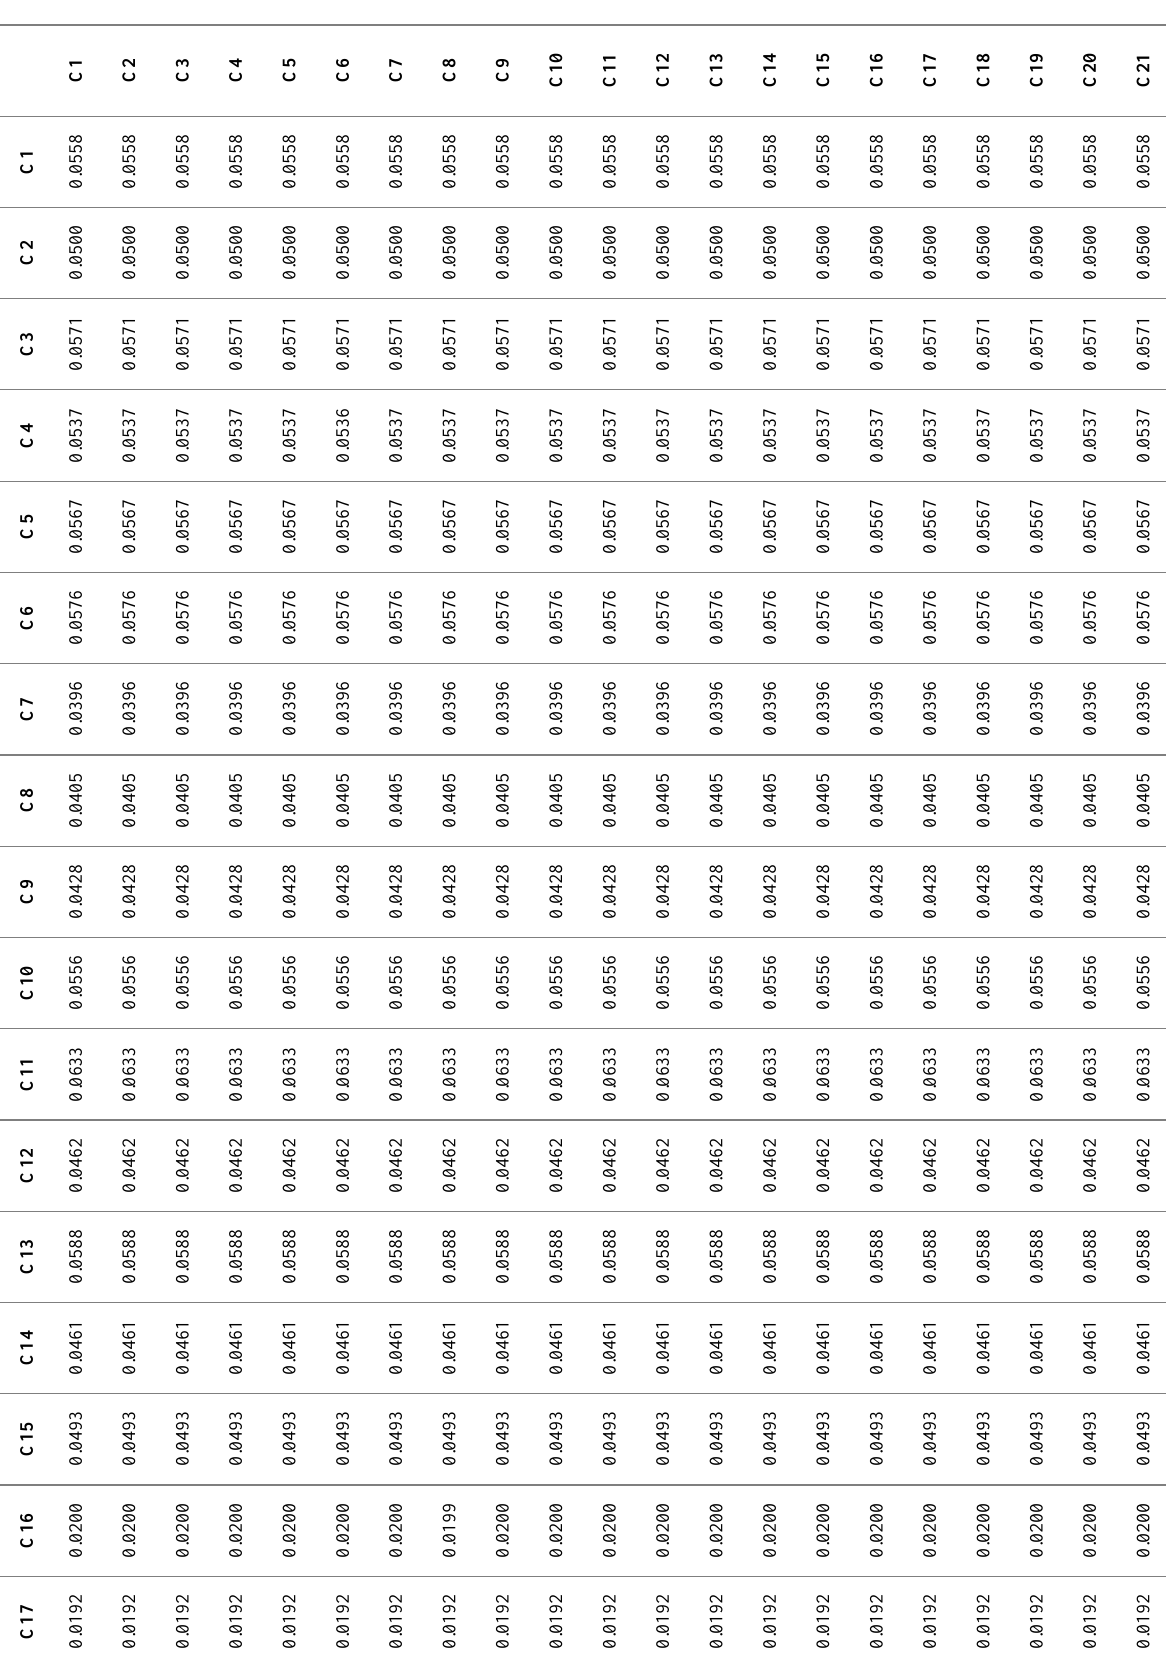
Table 14. Stable limiting weighted super-matrix while raising